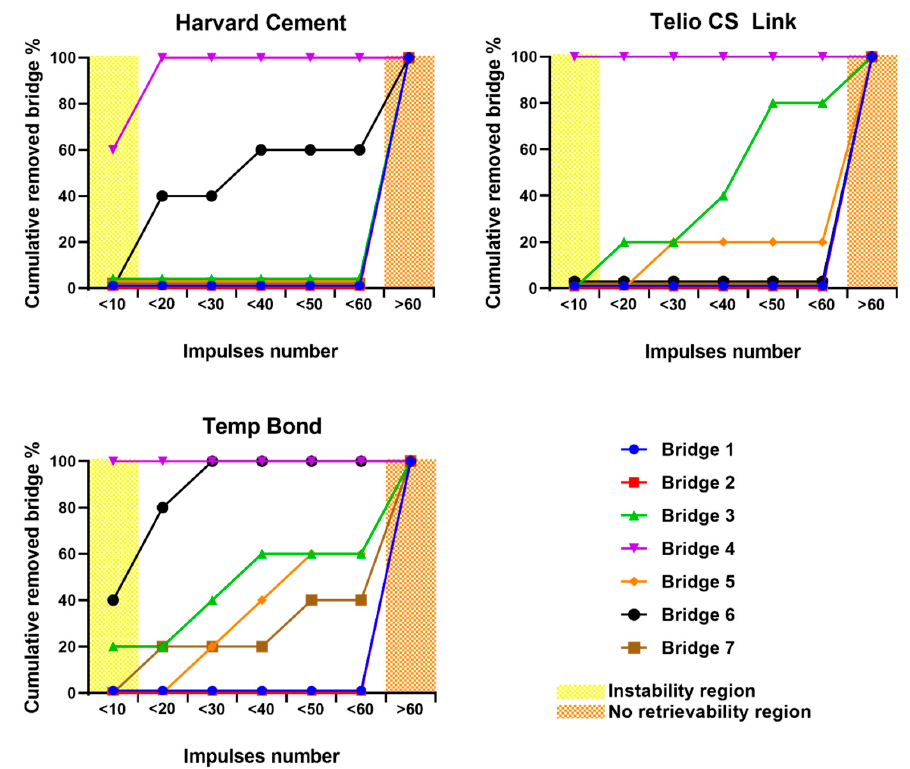
Figure 6. Removed bridges percentage vs impulses number. Each data point represents the total percentage of tests during which the bridge was removed within the corresponding number of impulses in the abscissa axis.